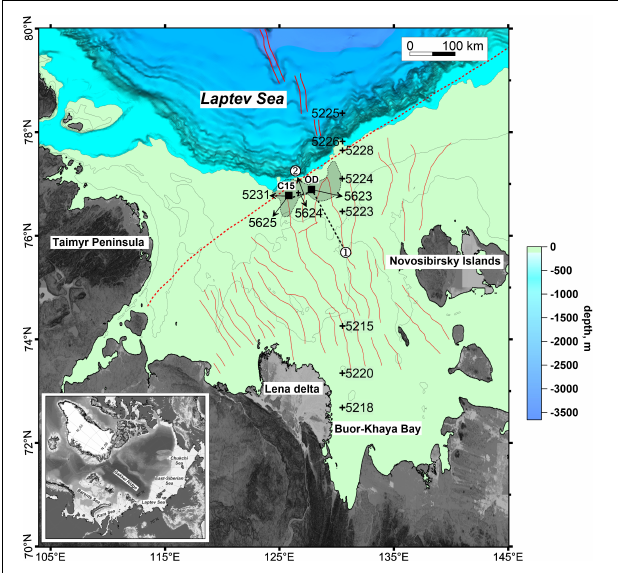
FIGURE 1 | Map of the study area in the Laptev Sea, grid is from IBCAO V.3 (Jakobsson et al., 2012). Contour lines of 100, 50, and 25 m are shown on the shelf. Filled squares mark the C15 and Oden ( OD ) study areas, crosses indicate sampling areas, thick lines 1 and 2 mark location of the profiles shown in Figure 2 . Gray color shows the domain of methane seep fields according to data from Shakhova et al. (2015). The double red line is the axis of the Gakkel Ridge, the dashed red line is the Khatanga-Lomonosov Fault Zone, and the red lines are the faults of the Laptev Sea Rift System (Drachev, 2000).